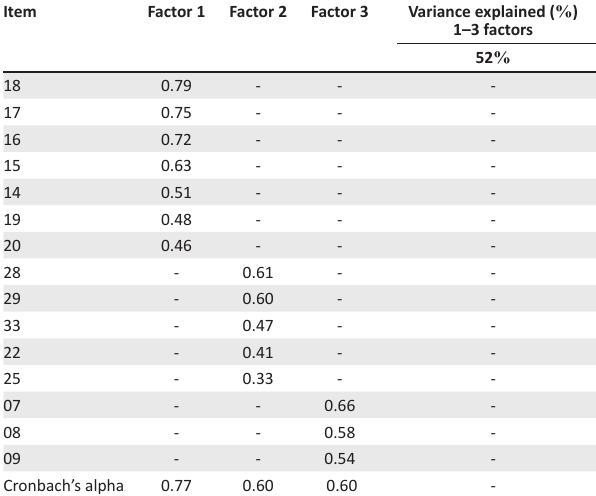
TABLE 1: Adult Learner Self-Directedness Scale factor